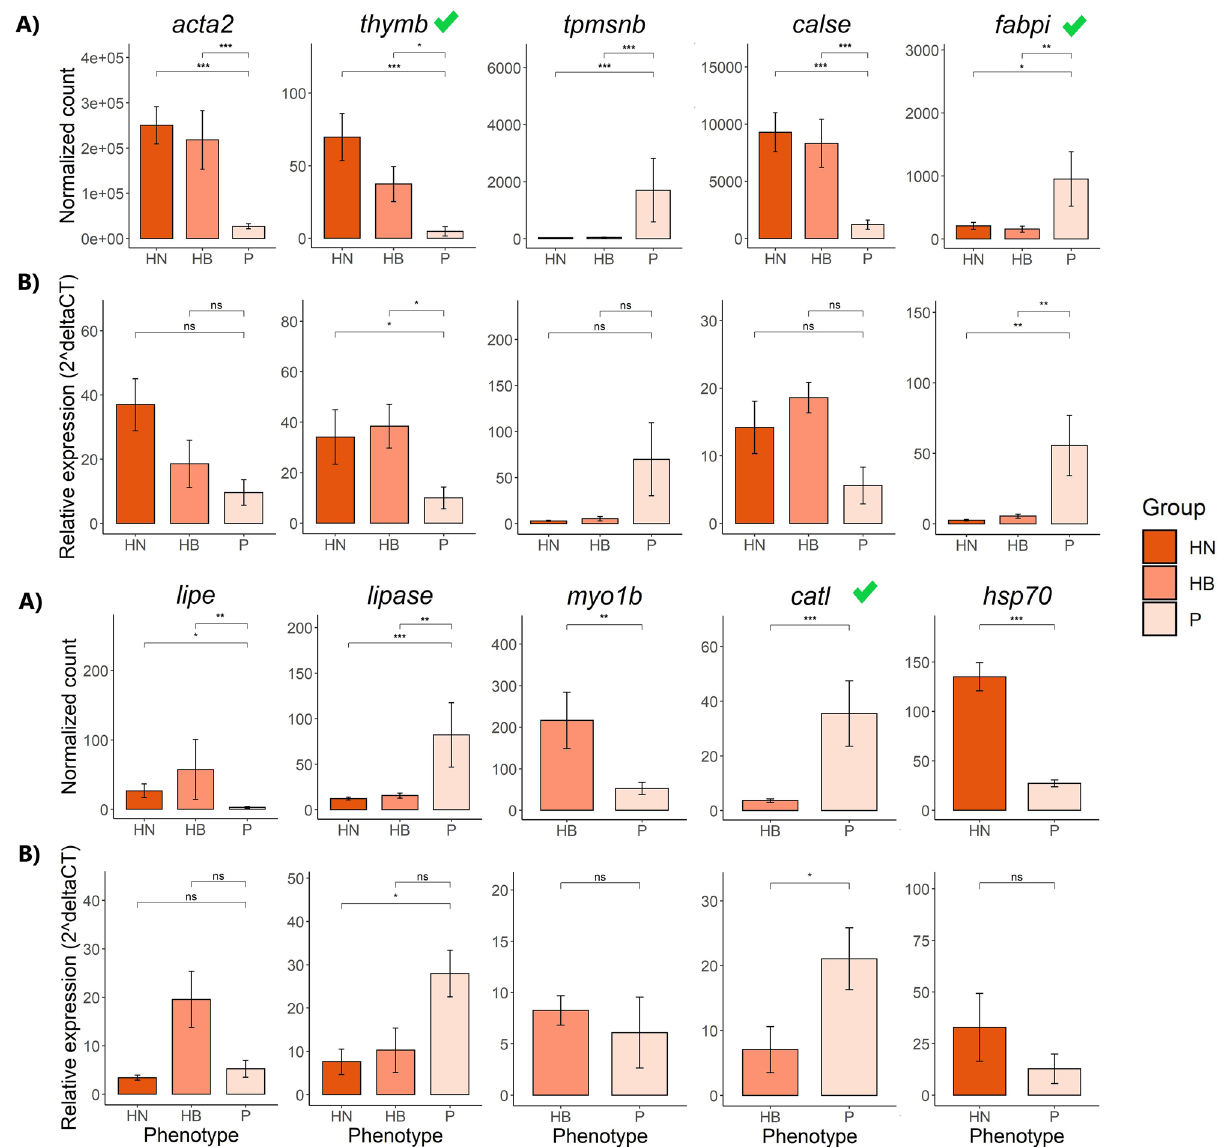
Figure 8. Differentially expressed genes in the back central region were validated using qPCR. Gene expression was calculated by normalized count in RNA-Seq ( A ) and relative expression in qPCR ( B ) in the comparisons of HN versus Pale and HB versus Pale. An average normalized count or relative expression across transcripts is shown. Data is shown as Mean ± SD. (n = 5/sample type). Kruskal–Wallis test was performed to verify any significant difference between the three phenotypes, then a multiple pairwise-comparison between groups was performed using pairwise Wilcoxon test. Means with asterisks indicate significant differences ( P < 0.05). A green tick indicates a confirmed DEG by